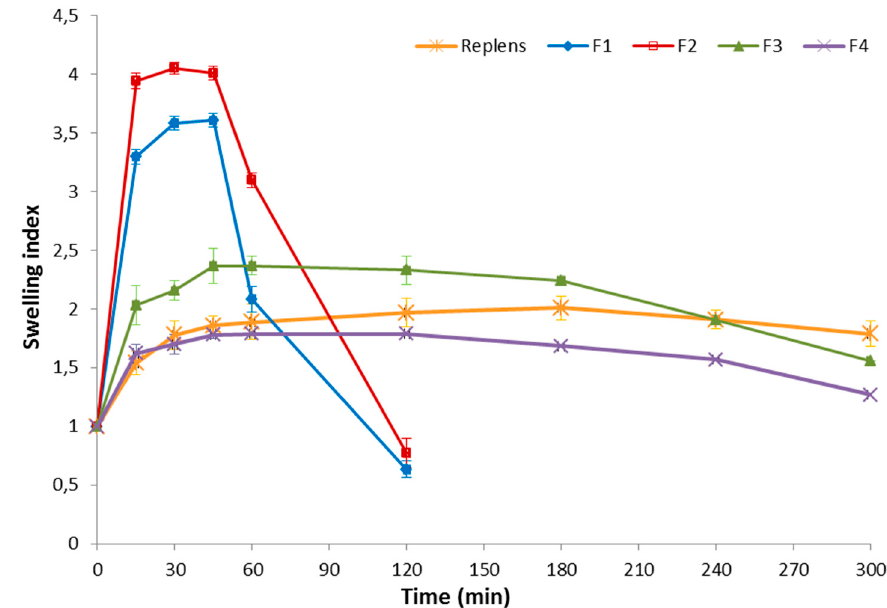
Figure 4. Swelling index study of CS formulations F1–F4 (mean ± S.D.; n = 3).